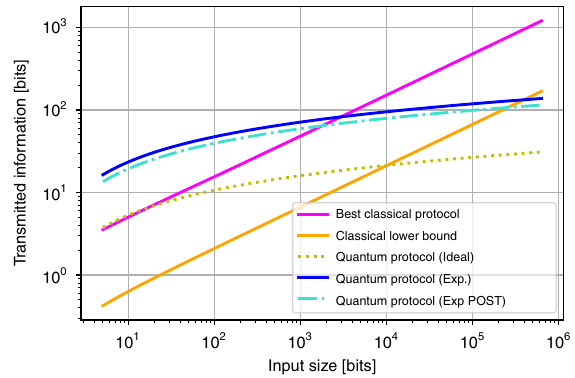
Fig. 8 Log – log plot of the transmitted information resource vs. the input size n for solving Hidden Matching within error probability p = 0.1. We error compare the best-known classical protocol, the classical lower bound, and the quantum coherent state protocol in the ideal setting, in the practical setting with the experimental parameters of Table 1, as well as in the post- selected case where Bob only outputs an outcome when he observes at least one click in the protocol run. The optimal mean photon number to obtain an error probability of 0.1 is j α j 2 (cid:9) 1 : 6 whereas j α j 2 (cid:9) 7 : 1. The ideal exp minimum input size needed for the coherent protocol to beat the classical protocol in the ideal, practical, and post-selected cases is n = 17/2926/ 1760, respectively. To beat the classical lower bound, the minimum input size for the coherent protocol in the ideal setting is n = 10189, whereas taking into account the experimental imperfections, n = 394272